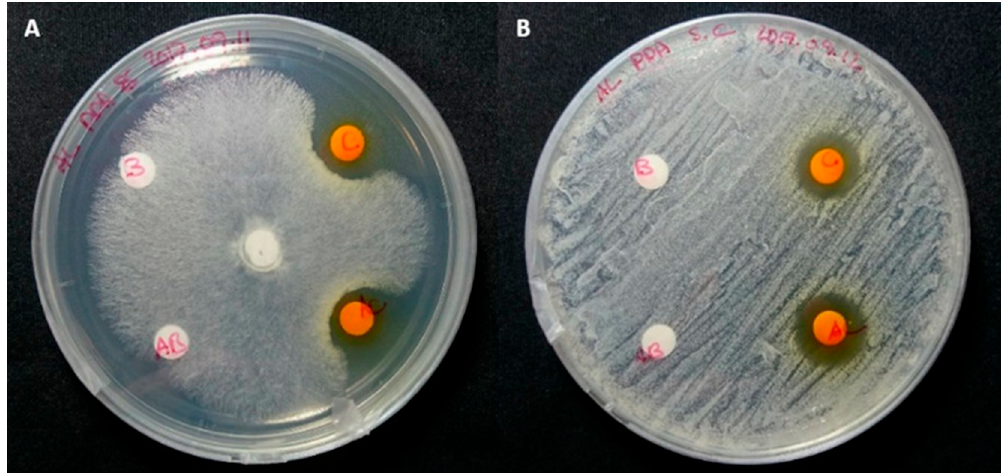
Figure 5. Example of the antifungal activity of a yellow compound purified from the crude methanol extract of Epicoccum nigrum ICMP 19927 and dissolved in sterile water. The photograph images show visual results of agar diffusion assay against Sclerotinia sclerotiorum ( A ) and Saccharomyces cerevisiae ( B ). Inside the plates: white paper discs are negative controls (sterile water) and yellow–orange disks contain purified antifungal compound. All fungal strains listed on Table 1 showed similar results. Molecules 2020 , 25 , x FOR PEER REVIEW